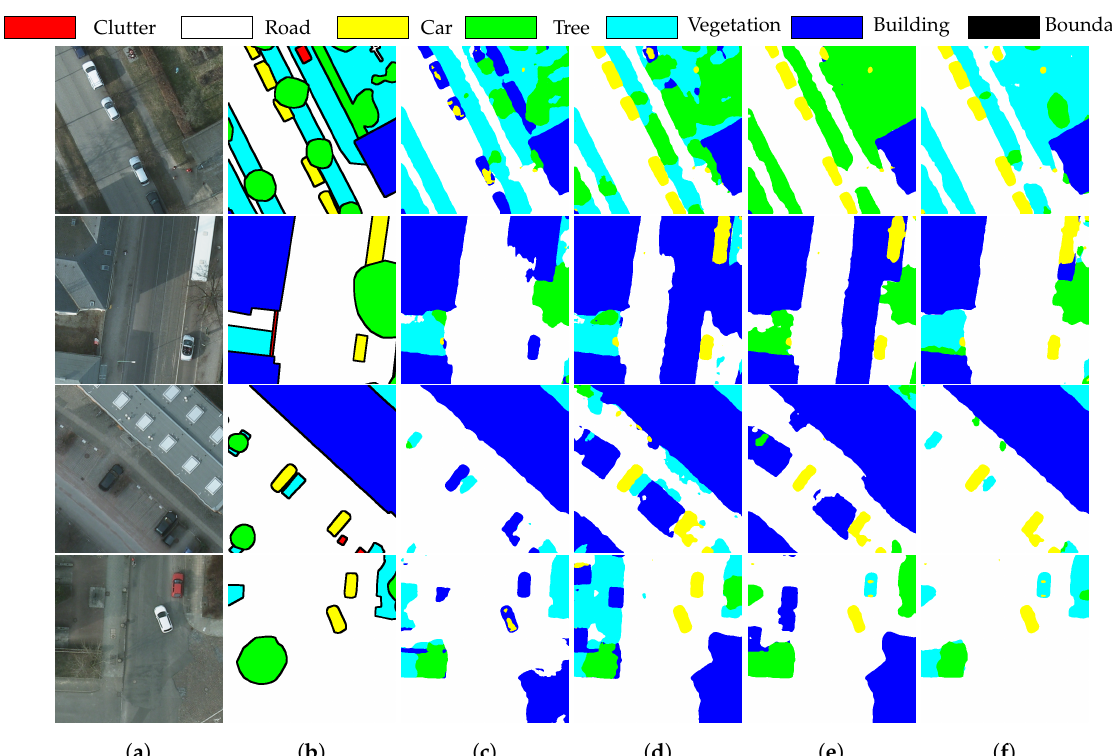
Figure 5. Predictions of the validation images from POT on VAI → POT. ( a ) Target images. ( b ) Ground truth. ( c ) Baseline. ( d ) Baseline with GCW. ( e ) Baseline with LDQ. ( f ) Baseline with GCW and